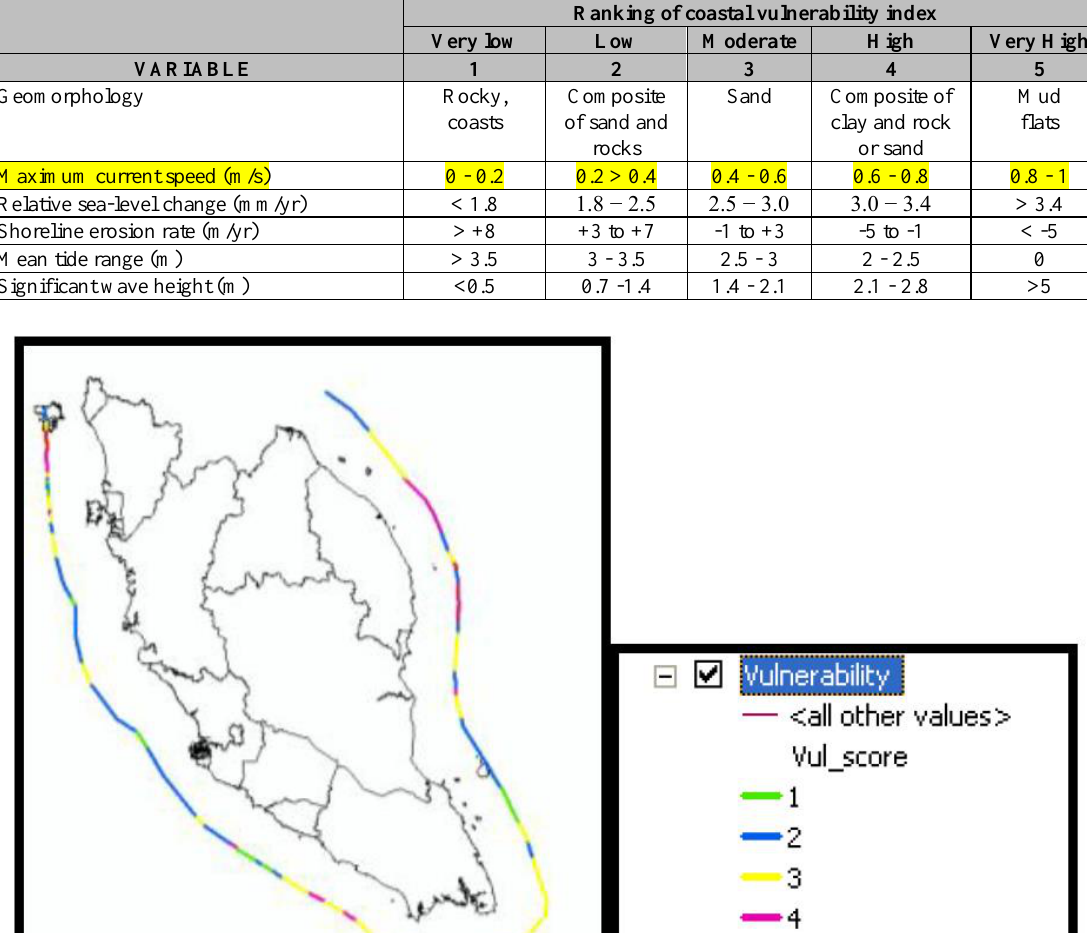
Table 5. Ranges for vulnerability ranking of variables along the Northern Gulf of Mexico Coast (Mohamad et al., 2014)